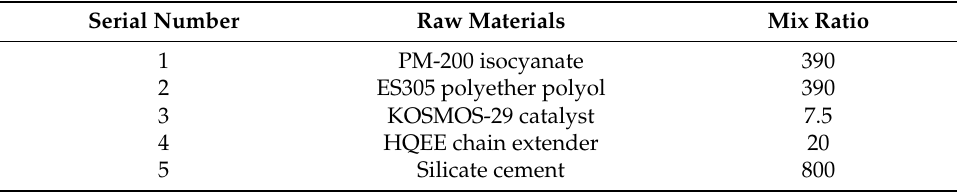
Table 6. The mix ratio of each raw material for this test(kg/m 3